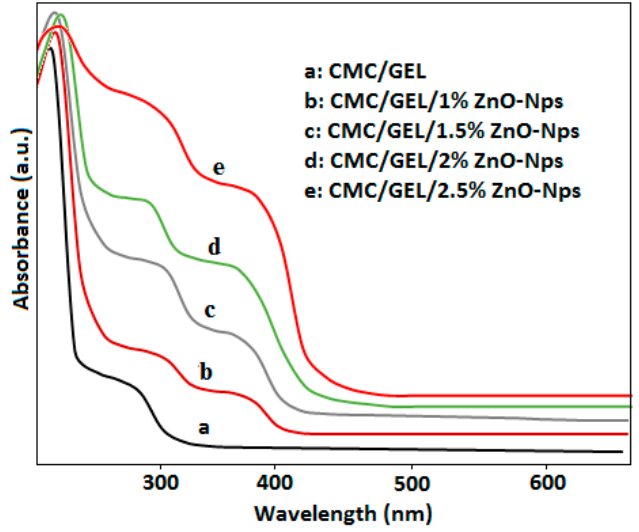
Figure 4. Optical studies of CMC/gelatin/ZnO-Nps.